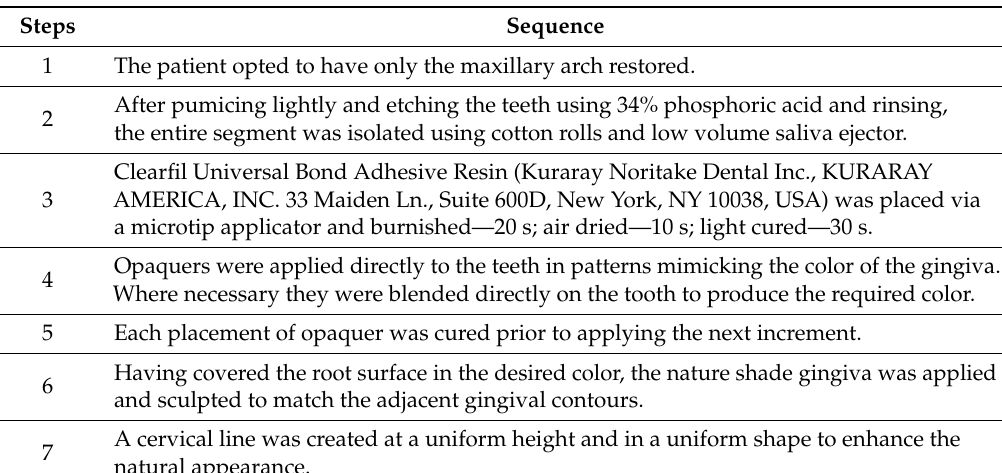
Table 2. Placement sequence for Amaris Gingiva-Colored Composite.